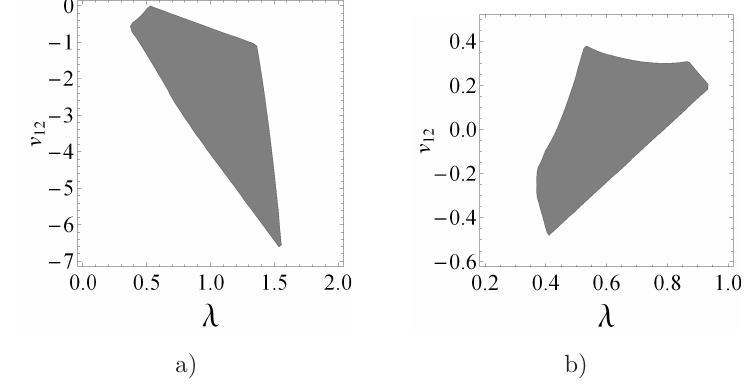
Figure 1. L -stable and A -stable methods with a) c = [1 / 3 , 2 / 3 , 1] T , b) c = [0 , 1 , 2]